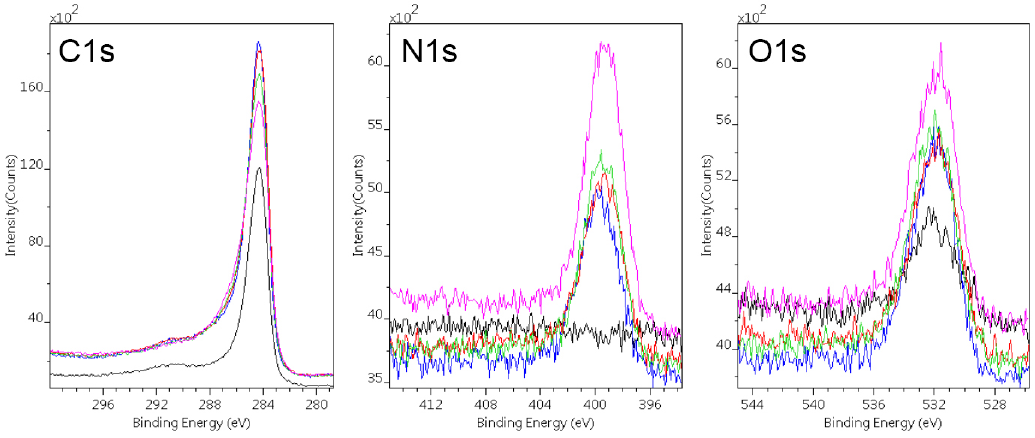
Figure 4: C1s, N1s and O1s lines of the GR samples treated at different bias (untreated black, 0 V blue, 50 V red, 100 V green, 200 V magenta) (colour online)